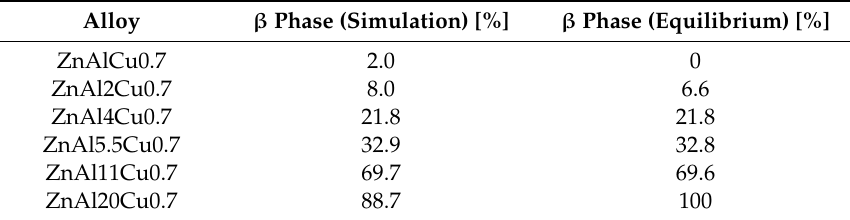
Table 2. β -phase fractions at 375 ◦ C representing the as-cast phase fraction immediately after Table 2. β-phase fractions at 375 °C representing the as-cast phase fraction immediately after solidification for alloys with di ff erent aluminum solidification for alloys with different aluminum concentrations.